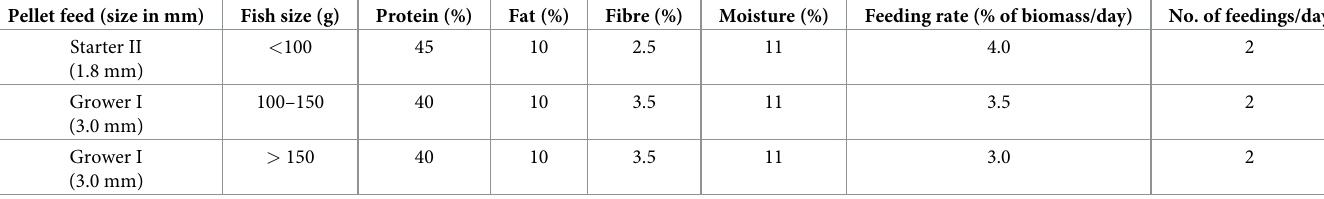
Table 1. Feed, proximate composition, and feeding rates of T . blochii during farming experiments. Pellet feed (size in mm) Fish size